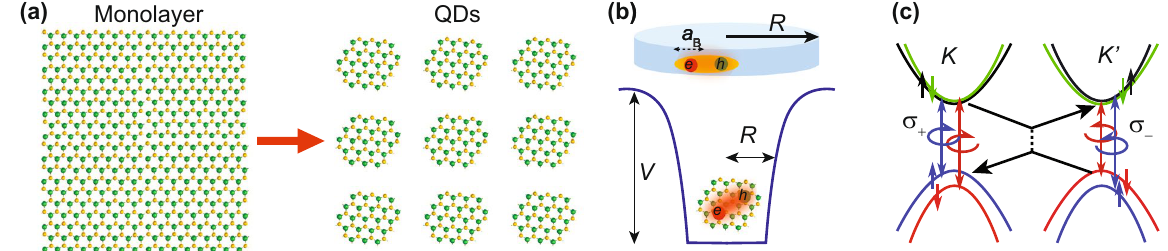
Figure 1. ( a ) Patterning of a 2D semiconductor into laterally-confined ML nanodots. ( b ) 2D confinement of excitons of Bohr radius a B in a potential well of radius R . ( c ) Spin-orbit coupling and inversion asymmetry in ML MoS 2 give rise to valley-specific coupling to circularly-polarized light. Confinement can potentially enhance intervalley scattering (black lines) and suppress valley polarization.